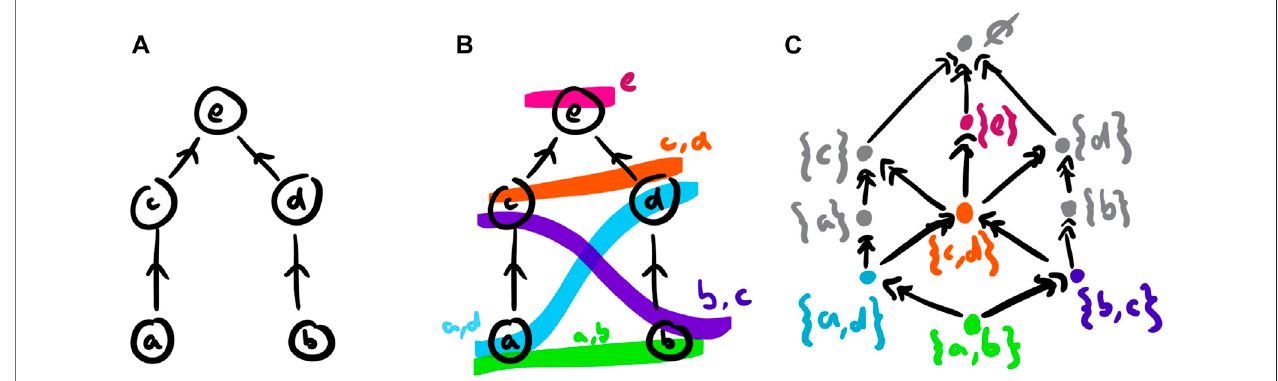
FIGURE 3 | (A) : the Hasse diagram for a causal order. (B) : the maximal slices for the causal order highlighted. (C) : the category of all slices for the causal